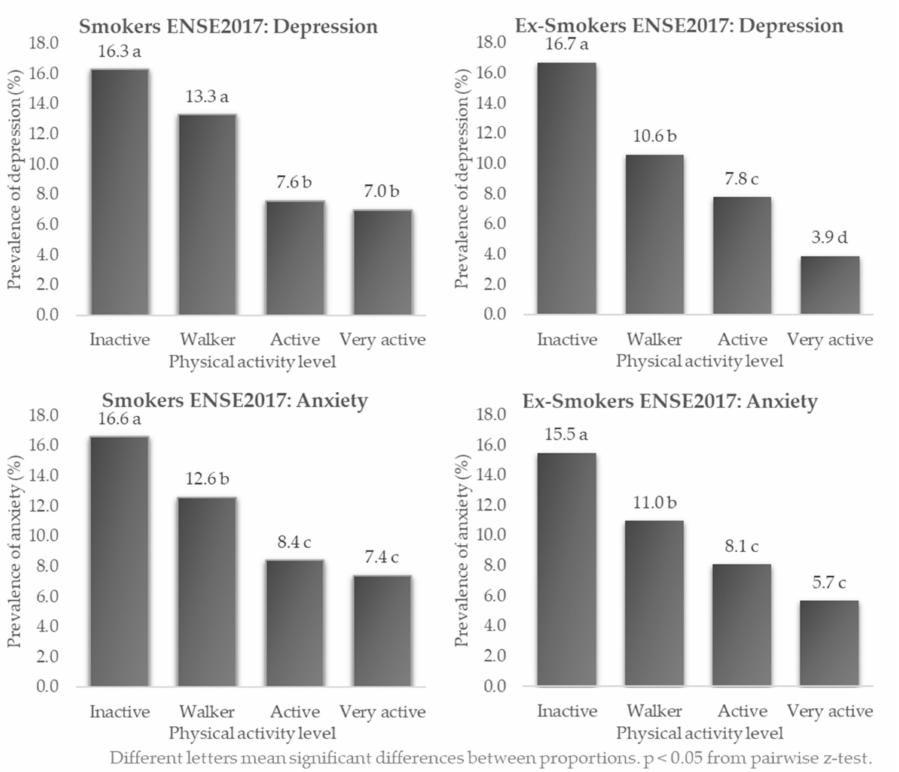
Figure 6. Prevalence of depression and anxiety in Spanish smokers and ex-smokers according to physical activity level.